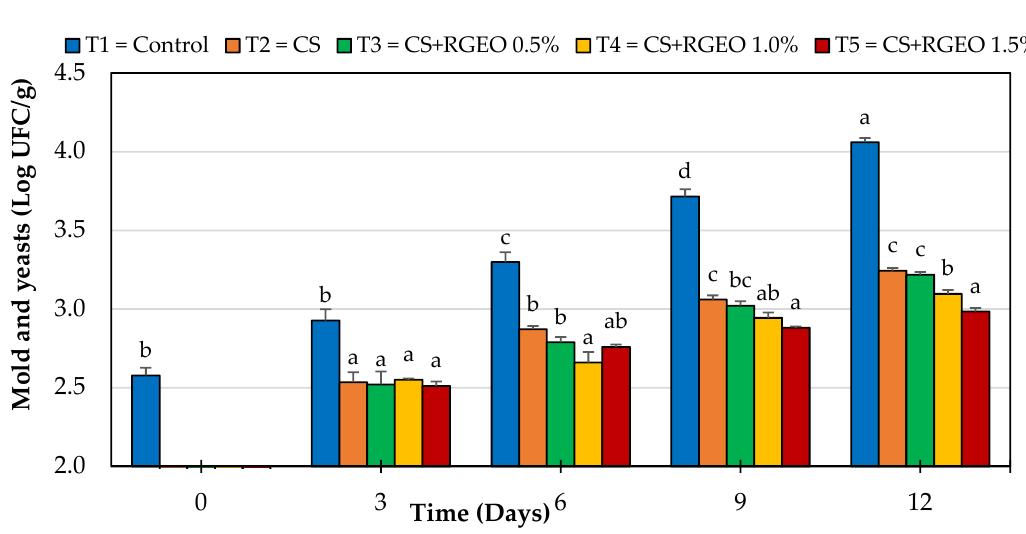
Figure 5. Mold and yeasts count for the treatments applied to cape gooseberry. The superscript letter (a–d) refers to the significant di ff erences ( p < 0.05) between each treatment. Significant di ff erences ( p < 0.05) between days and treatments concerning the growth of molds and yeasts at a confidence level of 95% were